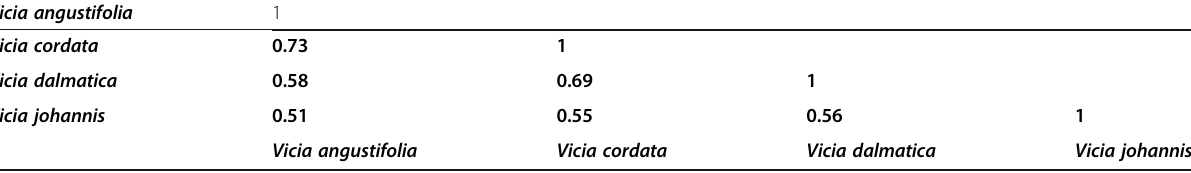
Table 2 Similarity matrix among studied Vicia species as computed according to Jaccard ʼ s coefficient as revealed by protein